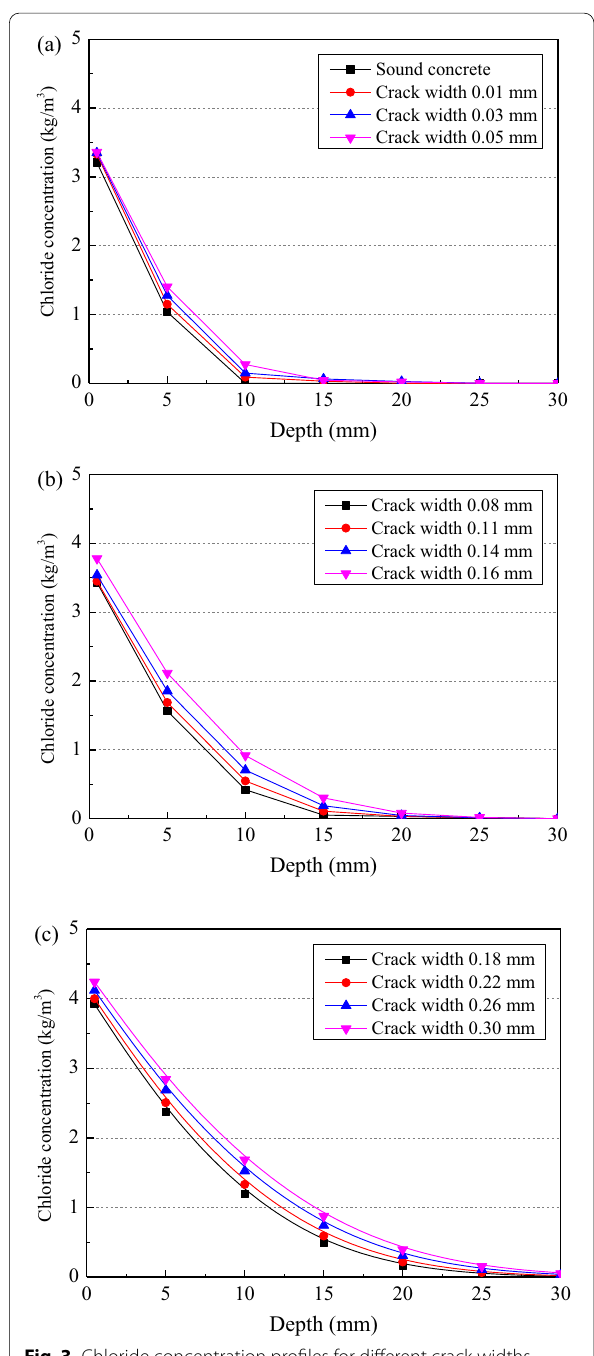
Fig. 3 Chloride concentration profiles for different crack widths.